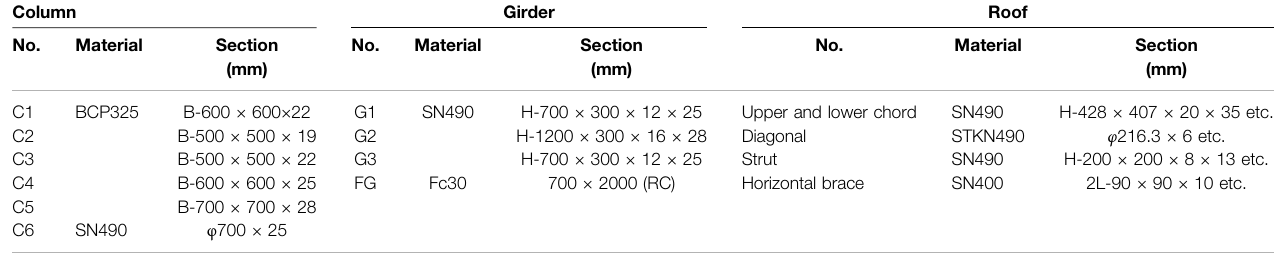
TABLE 1 | Member speci fi cations. Column Girder No.